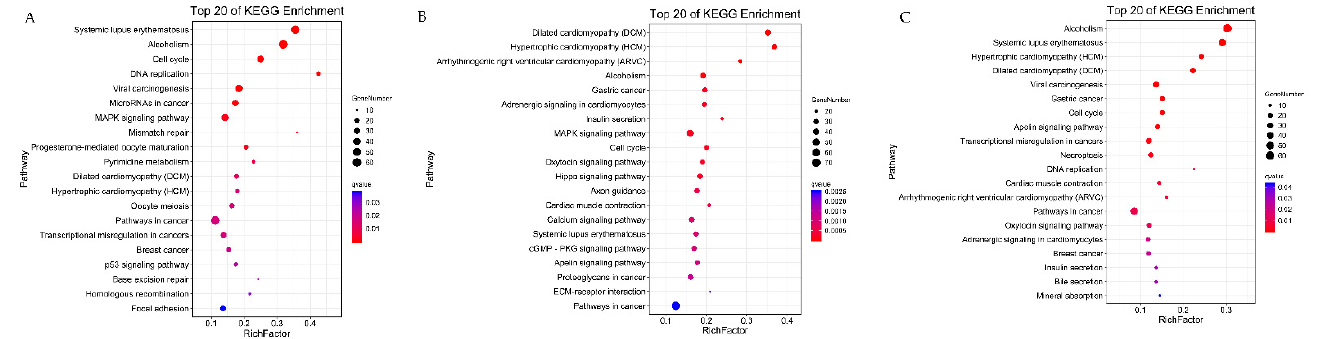
Figure 6 . Bubble plot of the top 20 significance pathways of KEGG enrichment. ( A ) The top 20 significance pathways in GM vs. DM1; ( B ) the top 20 significance pathways in GM vs. DM5; ( C ) the top 20 significance pathways in DM1 vs. DM5. The color of the circle represents the q value, which is adjusted to the p -value by multiple hypothesis testing. The size of the circle indicates the number of annotated differentially expressed genes.